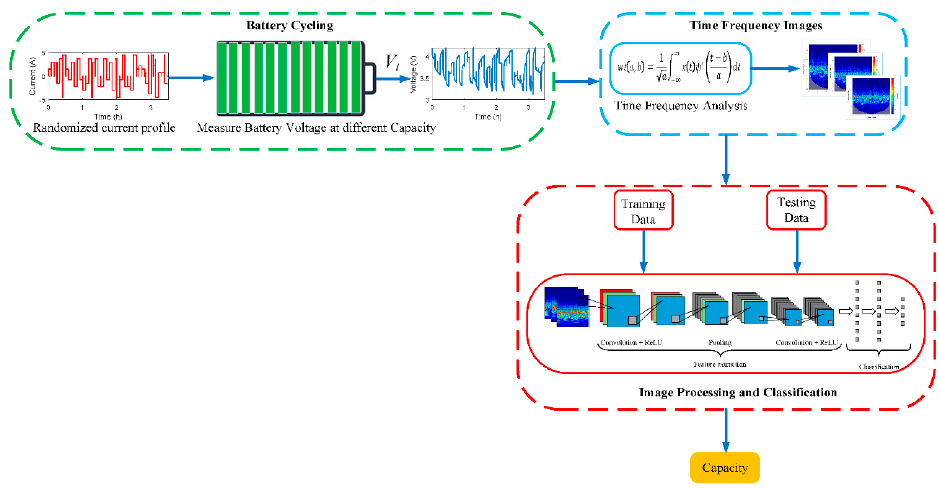
Figure 5. General flow chart of the proposed method for TFI capacity estimation.